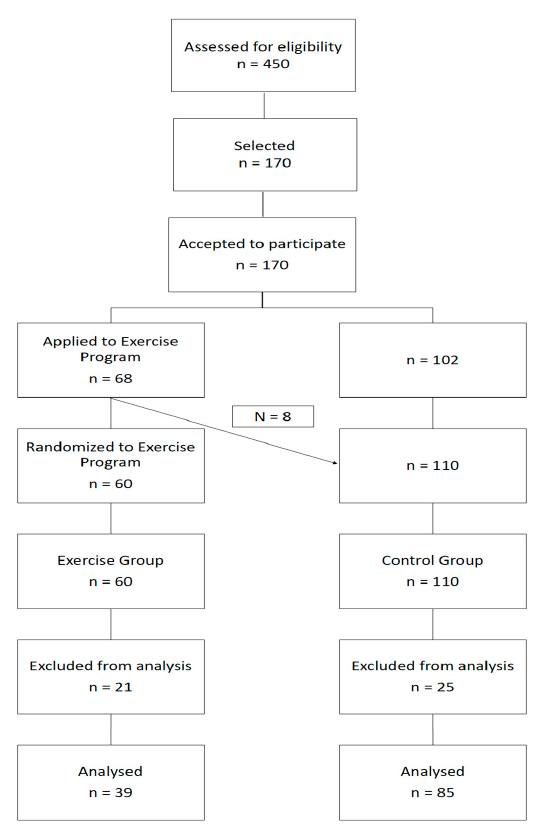
Figure 2. Sample diagram.